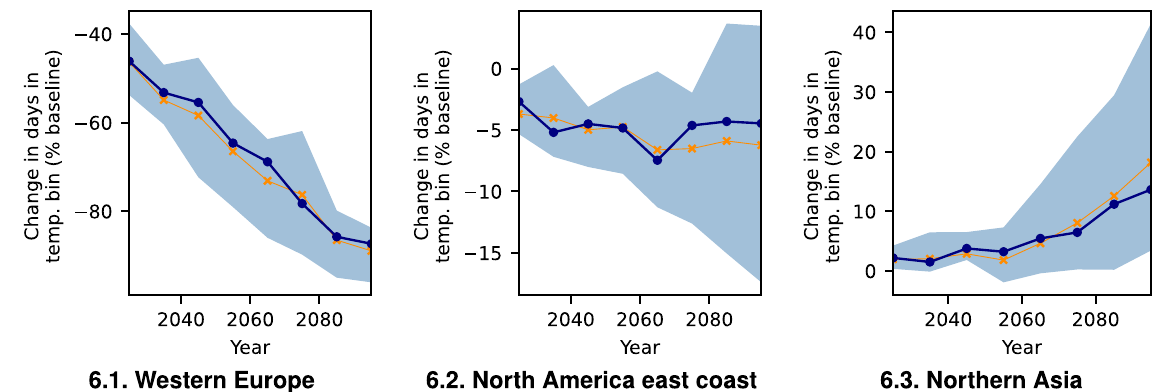
Figure 6. Regional differences in the trend of number of days with surface temperature between − 2.5 ◦ C and − 1.5 ◦ C (elevation below 1000 m, decadal statistics, SSP5-RCP8.5). All values are relative to the baseline (1851–1920) climate. Blue line shows the model ensemble median, shaded areas denote the likely range (16.7th to 83.3rd percentiles). Orange line shows statistics for all ten models combined into one time series